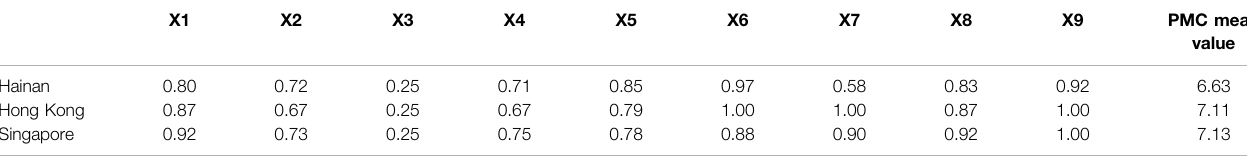
TABLE 6 | Mean values of fi rst-level indicators of national park policies in Hainan, Hong Kong and Singapore.